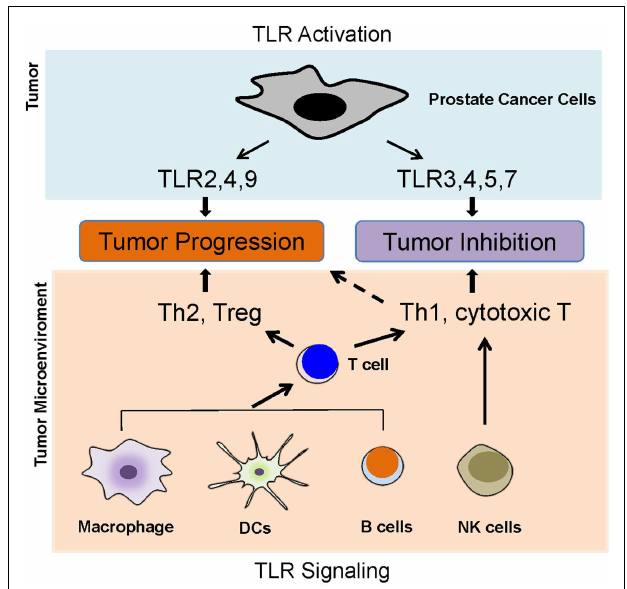
FIGURE 2 |Toll-like receptors and prostate cancer .TLR activation in tumor cells and its activation in tumor microenvironment such as in typical innate immune cells lead to a complex scenario, which determines the role ofTLRs in prostate cancer development.The activation ofTLRs in antigen-presenting cells, such as DCs, macrophages, and B cells, can lead to eitherTh1 andT cytotoxic responses orTh2 andTreg responses.The activations ofTLR2, 4, and 9 in prostate cancer cells appear to promoter tumor growth, but the activation ofTLR3, 4, 5, and 7 might inhibit prostate